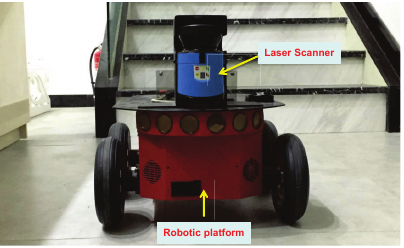
Figure 1: A photo of the mobile UGV used in our paper, which is comprised of a laser scanner SICK LMS-100 and a robotic platform Pioneer